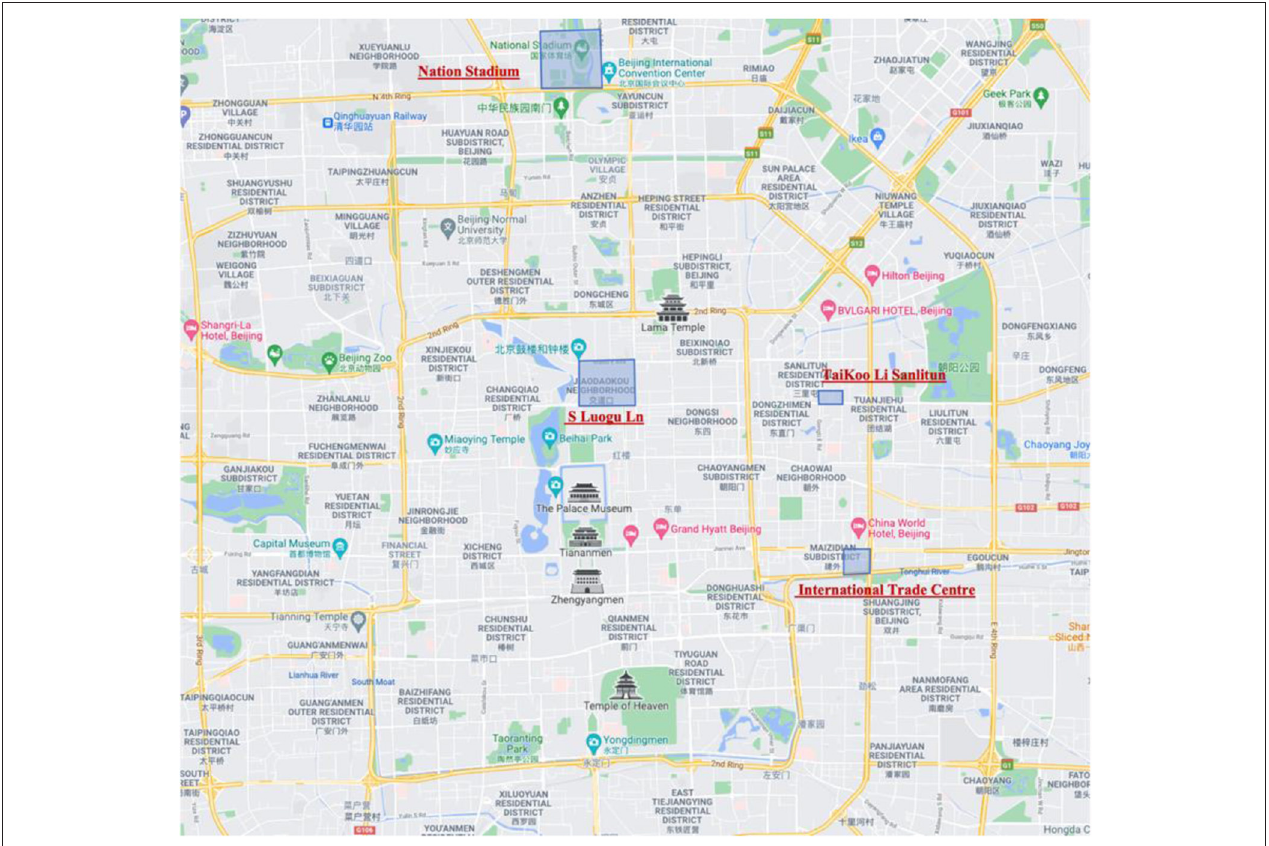
FIGURE 6 | The location of the four areas and the names of the surrounding